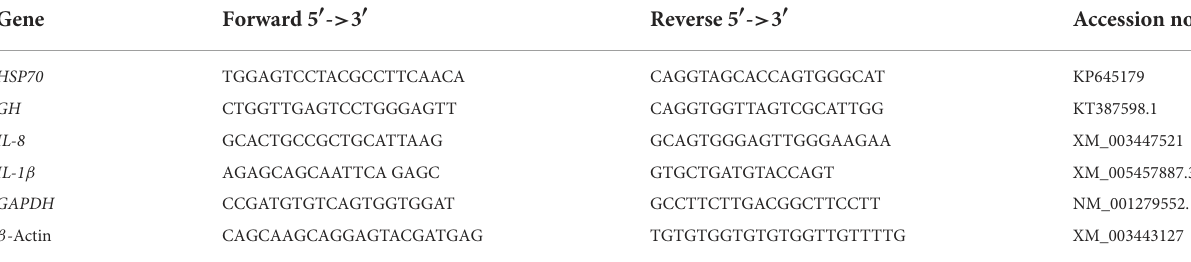
TABLE 2 The sequences of applicable primers used for real-time q-PCR investigation of gene expression. Gene Forward 5 ′ - > 3 ′ Reverse 5 ′ - > 3 ′